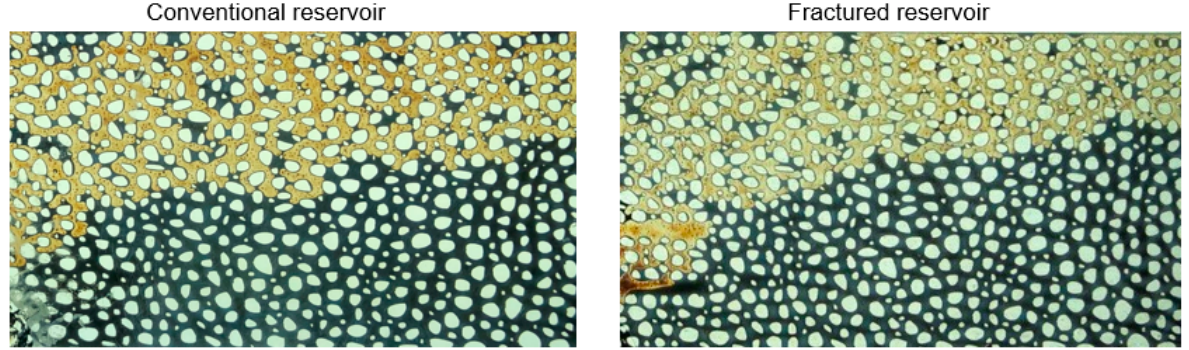
Figure 21. The VAPEX processes in the conventional and fractured reservoirs.